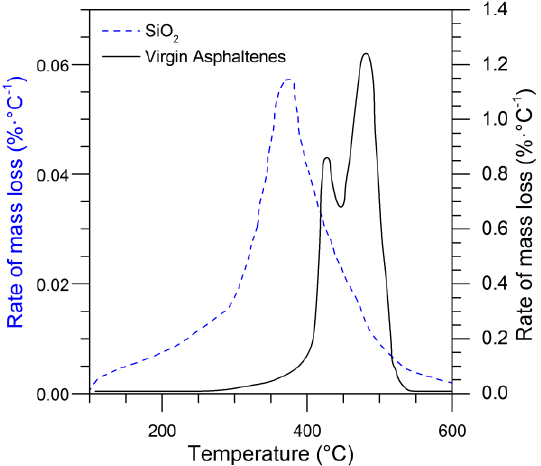
Figure 16. Rate of mass loss as a function of temperature (DTG) and in an air atmosphere of virgin asphaltenes and asphaltenes adsorbed over silica nanoparticles. The heating rate was 10 °C·min −1.